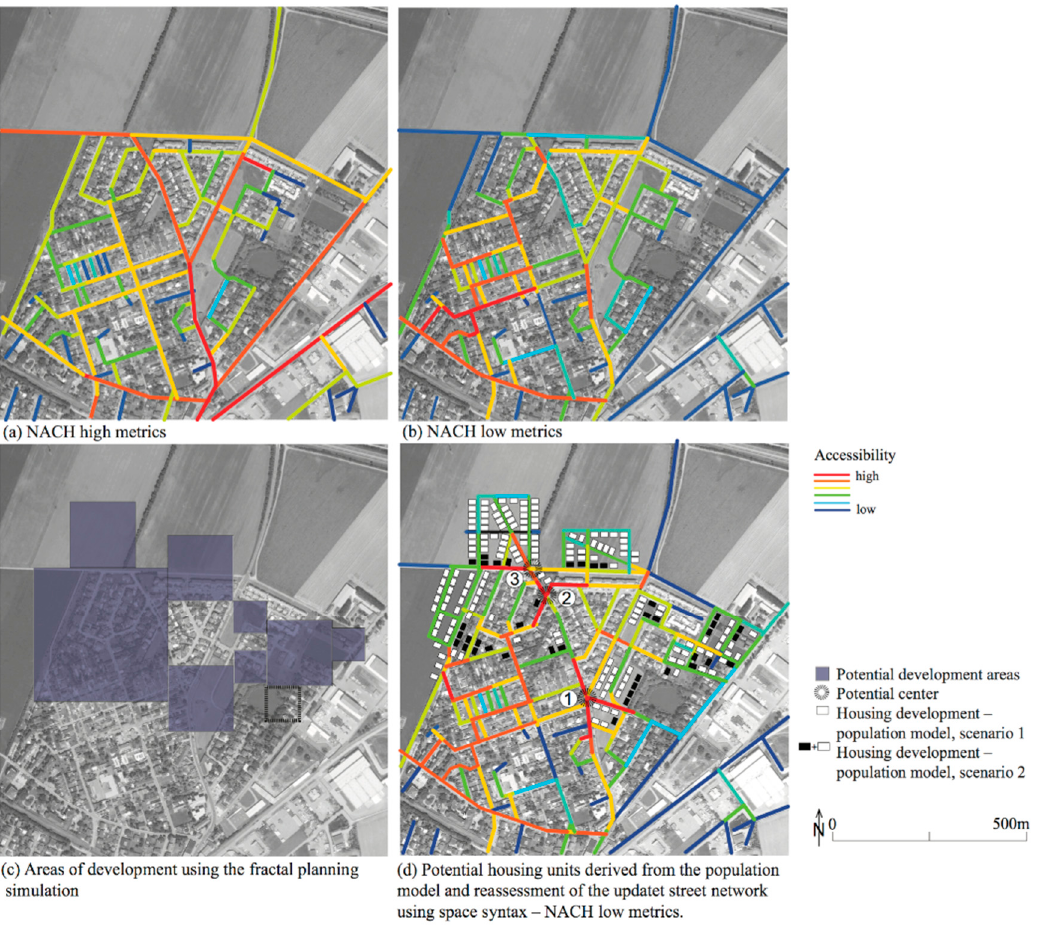
Figure 7. An integrated modeling approach on a local scale: ( a ) NACH high metric radius depicts highly accessible roads penetrating the neighborhood’s core: ( b ) NACH low metric radius 800 m highlights an unsustainable street network for pedestrian movement; ( c ) the multifractal planning logic includes potential residential development; and ( d ) NACH low metrics indicates a street network with higher accessibility and potential locations for a local center with new functions. (Background image: google earth). Table 5. Means of syntactic measurements for the existing street network and the locations for a potential local center with shops.